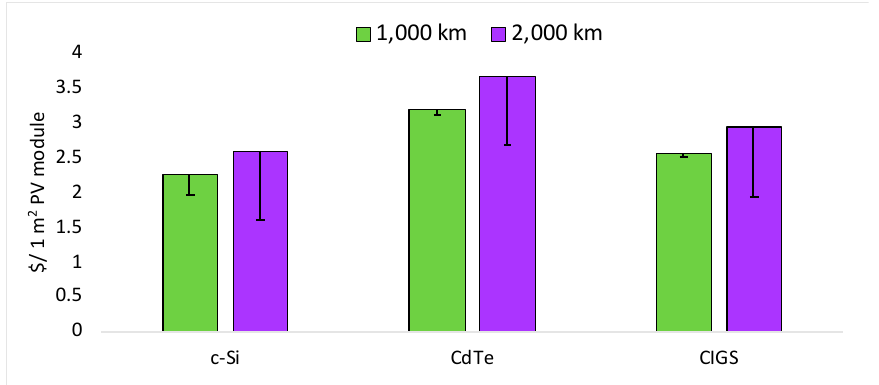
Figure 1. The cost of transportation of different type PV modules with diesel-fueled trucks (note that after 1500 km the unit cost (USD/km) of truck transportation decreases about 40%).